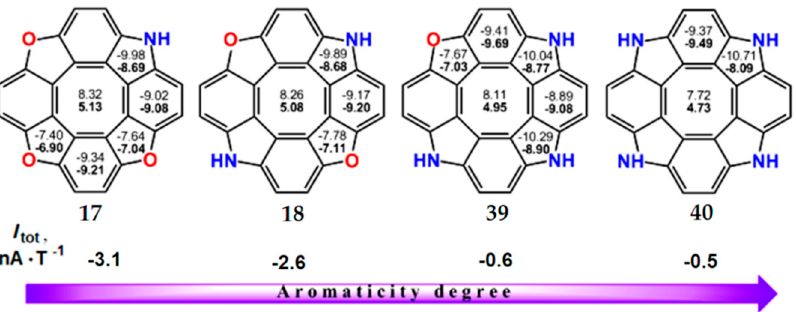
Figure 11. The NICS(0) (top number) and NICS(1) (bottom number in bold) indices in the aza[8]circulene series and the total ring current strength ( I tot ), calculated by the GIAO/B3LYP/6-311++G(d,p) method. Table 3. The total ring current strength ( I tot , nA ∙ T –1 ) and the balance between the diatropic ( d ) and paratropic ( p ) currents in the rim - and hub -subsystems for the neutrally and doubly charged hetero[8]circulene molecules. Circulene.